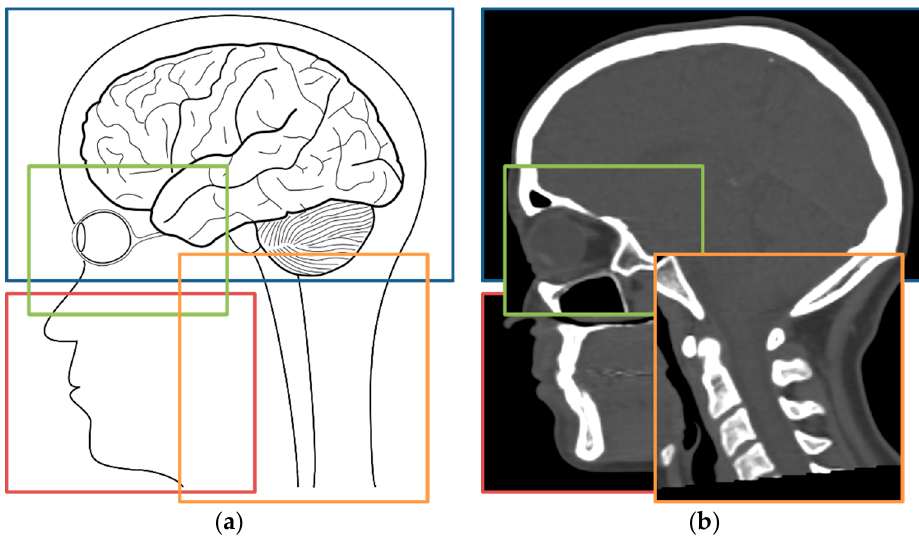
Figure 1. Head and neck whole field of views (FOVs) could be generated from joining several smaller parts from different patients as shown in the anatomical drawing in ( a ). Thus, overlapping incomplete CT scans such as a brain (blue box), facial orbits (green box), maxillofacial (red box), and neck (orange box), as shown in ( b ), could be equivalent to having a single scan covering the same FOV regarding pseudo-computerized tomography (pseudo-CT) synthesis pipelines.